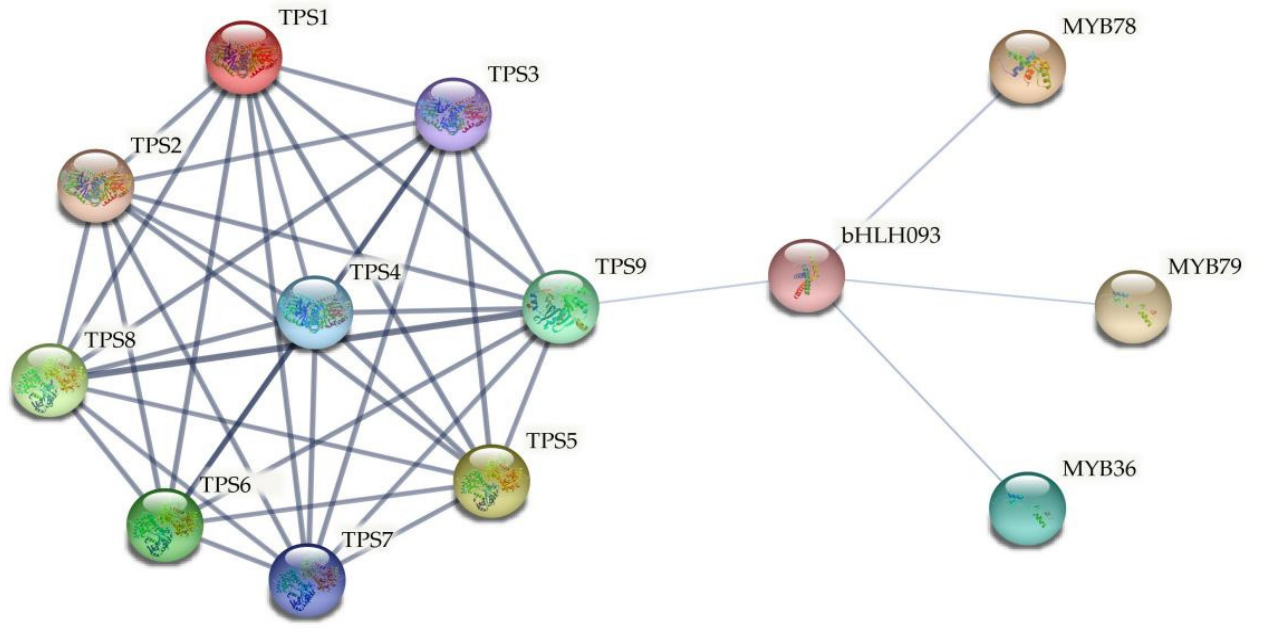
Figure 9. Functional protein association networks using the TAIR accessions of